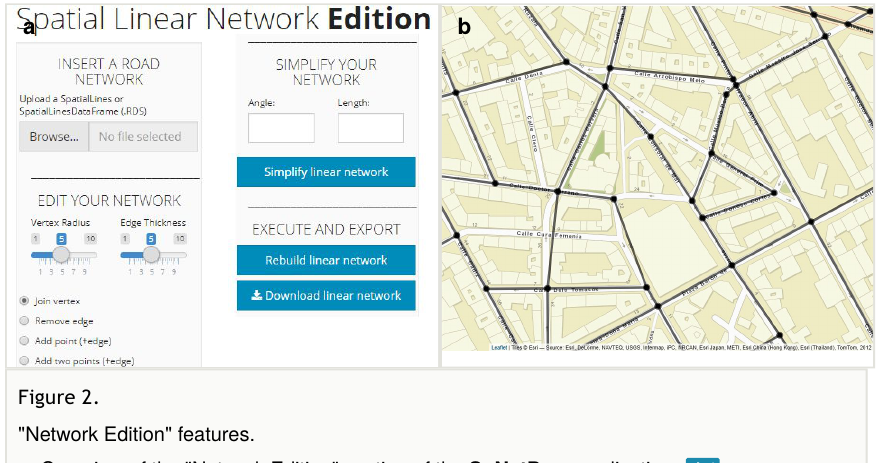
"Network Edition"